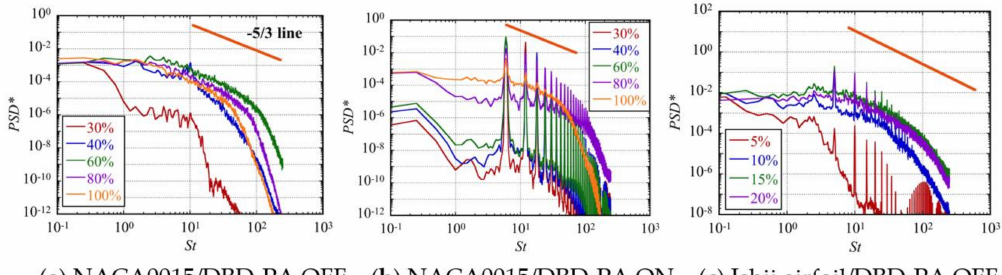
Figure 16. Power spectrum density of the chordwise velocity fluctuation at several locations [50]